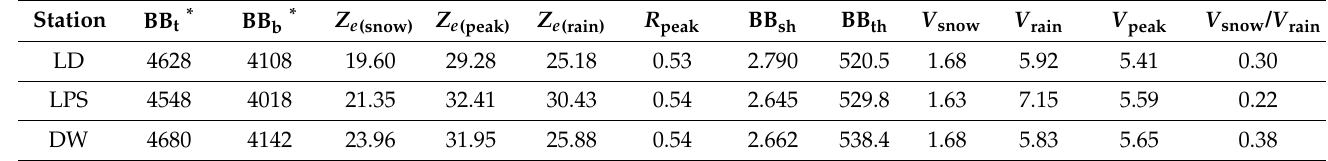
Table 1. Modes of BB characteristics—top height (BB t ), bottom height (BB b ), thickness (BB th ), sharp- ness (BB sh ), peak reflectivity [ Z e (peak) ], and relative peak position ( R peak )—for the stratiform precipita- tion reflectivity profiles measured during May to September 2021 at LD, LPS, and DW.